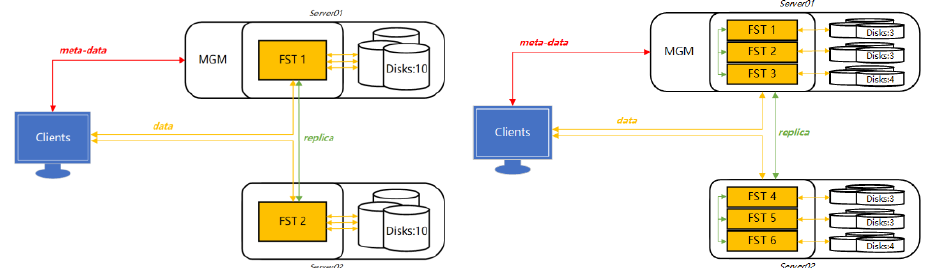
Fig. 4. The development of 2 FSTs and 6 FSTs in two-replica mode